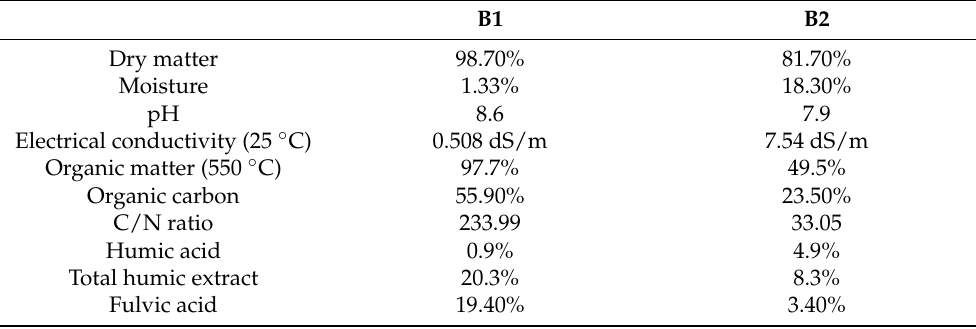
Table 1. Basic properties of the two types of biochar used in the experiments. B1: Biochar type 1, B2: Biochar type 2.